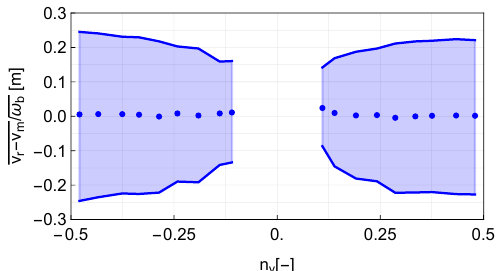
Figure 9. Mean normalized error between the modelled 𝑣 𝑚 and the measured 𝑣 𝑟 blade signals for different values of the transverse component 𝑛 𝑦 of the line-of-sight vectors. The blue shaded area depicts the upper and lower outer fences of the relative difference of the two statistical quantities. The values of each 10 min period were normalized by the corresponding mean rotor